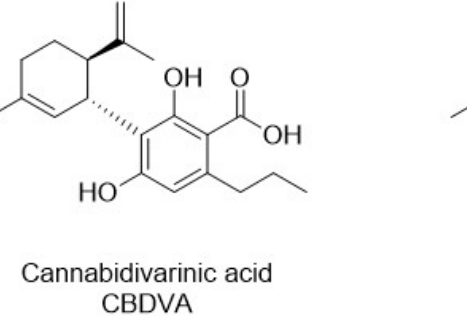
Figure 4. The chemical structure of CBDVA and CBDA.